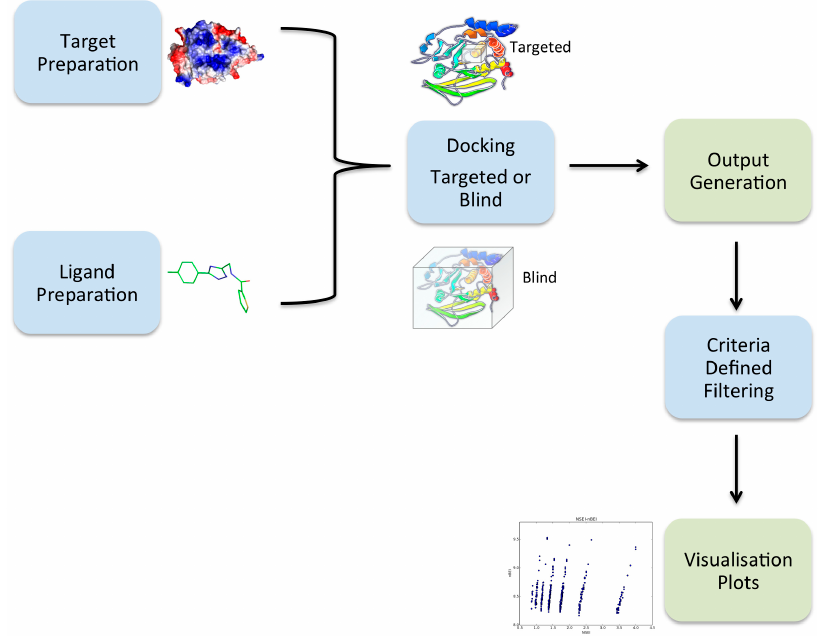
Figure 1. Overview of the VSpipe workflow. The diagram highlights the main steps that take place during VSpipe. The blue boxes show the tasks VSpipe performs after reading input information by the users, whilst the green boxes represent outputs ready for analysis.